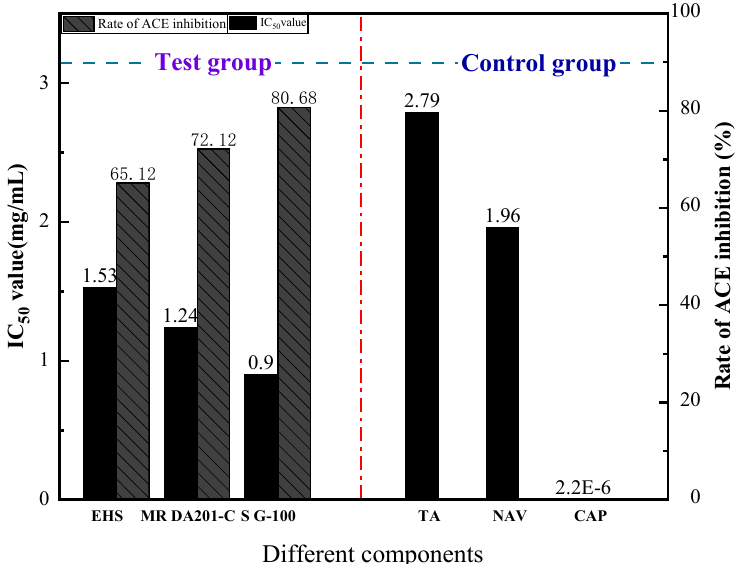
Figure 11. Changes of ACE activity at different preparation stages. “EHS” means enzymatic hydrol- ysis solution, “MR DA201-C” means the highest active component after purification with macroporous resin DA201-C, and “S G-100” means the highest active component after separation with Sephadex G-100. “TA”, “NAV” and “CAP” stand for Triticum aestivum, Navodonseptentrionalis and captopril, respectively.